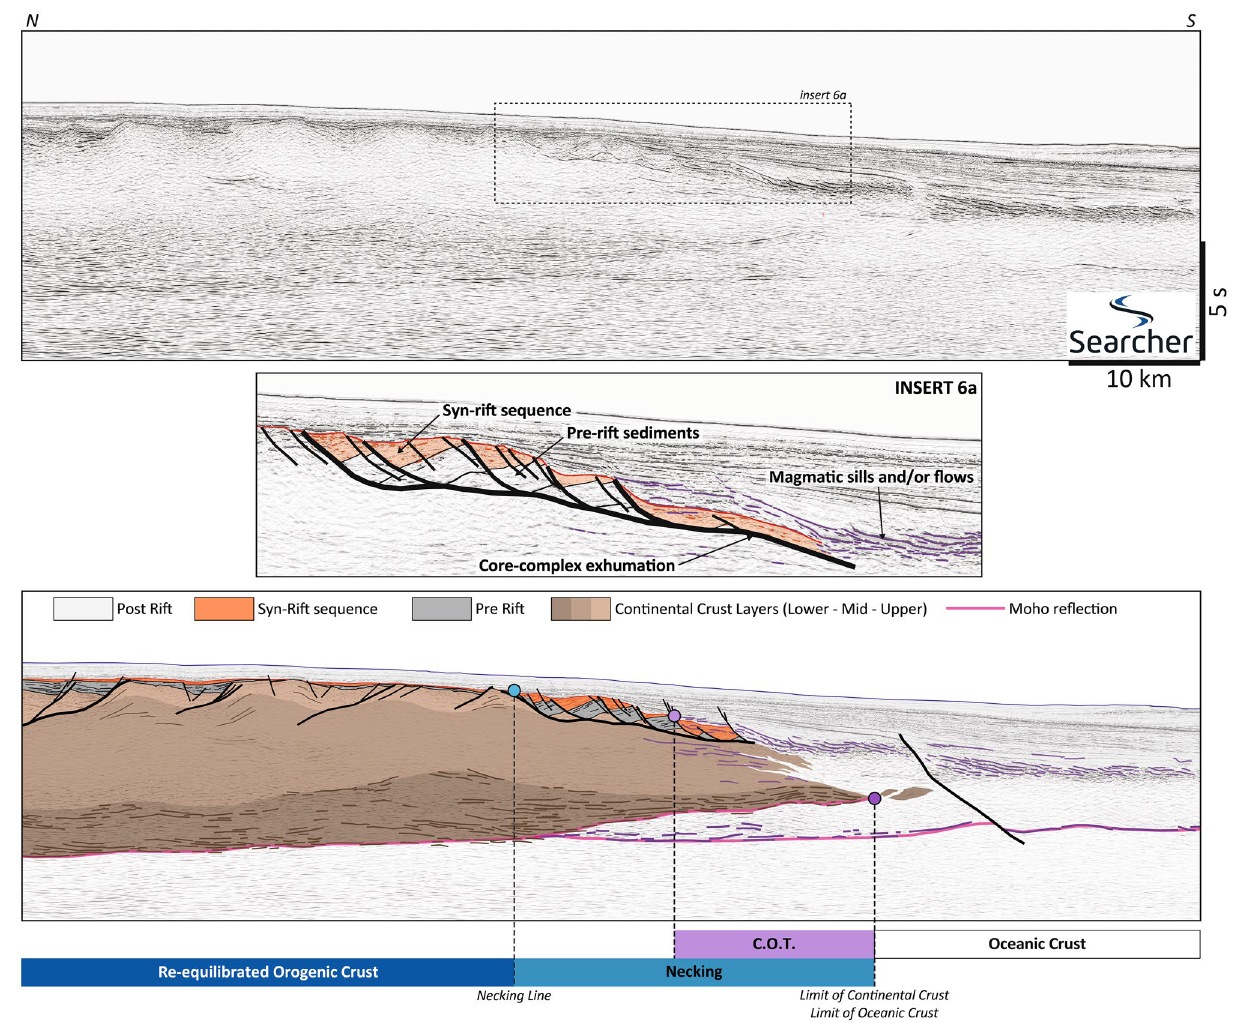
Figure 6. North Coral Sea case study. The section crosses a proximal domain in a continental crust already thinned (23–24 km). The final thinning of the crust is expressed on a single shallow detachment and important shear structures in the lowermost crustal layer. The necking zone is short. Breakup is rapid with short OCT leading to a classic oceanic crust in terms of thickness but with a peculiar upper layer made of interactions between magma (intrusive and effusive) and locally high sedimentation. The data are courtesy of